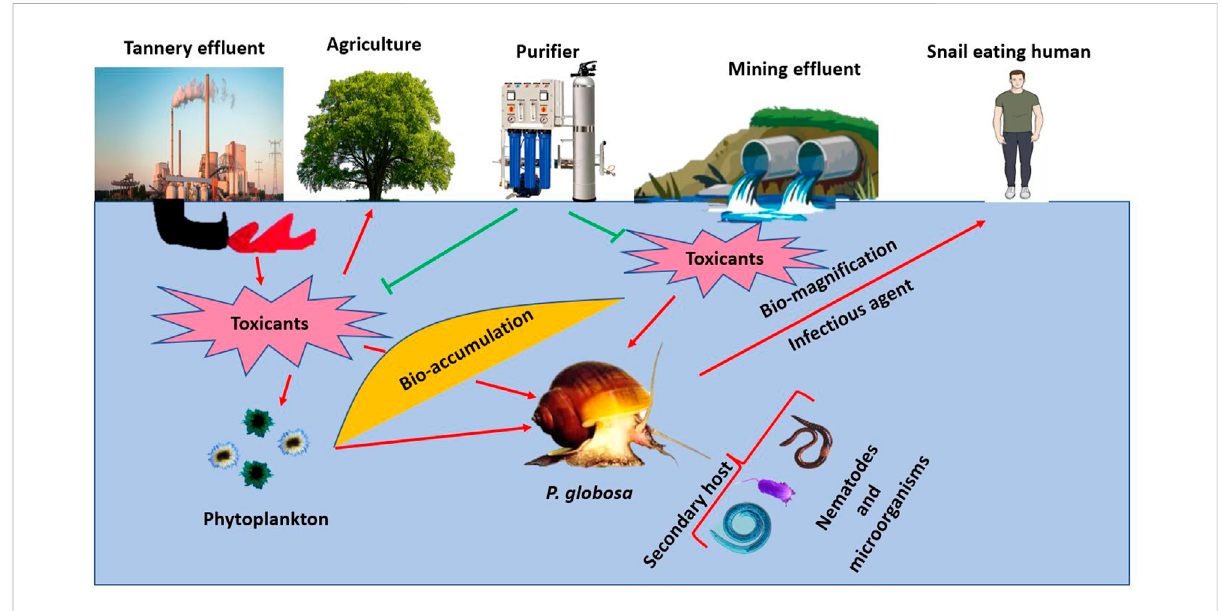
FIGURE 5 Effect of environment on P. globosa and ultimately on humans. Toxicants released from mining and industries are absorbed by phytoplanktons that are consumed by the snails. Because this animal is used as a diet by humans, especially in rural areas, the chances of biomagni fi cation of toxicantsare veryhigh. P.globosa also actsas asecondaryhostfor parasites likenematodesand microorganisms,which islikelytobetransmittedto snail-eating